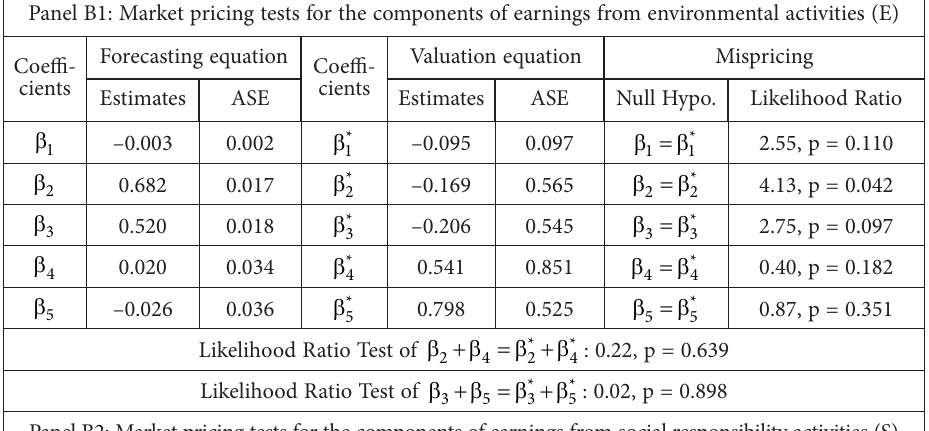
Panel B2: Market pricing tests for the components of earnings from social responsibility activities (S) Coeffi-